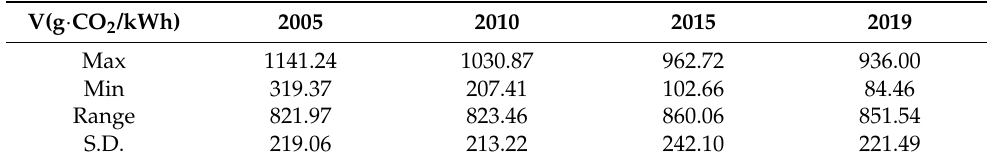
Table 2. Statistical information of provincial